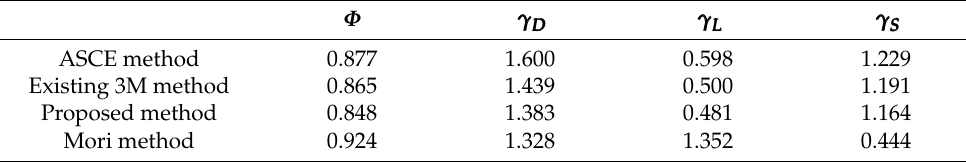
Table 4. Results of load and resistance factors calculated using different methods.